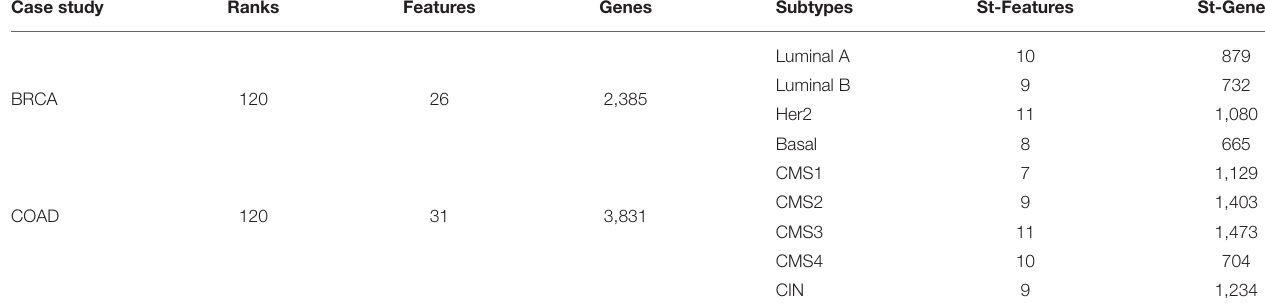
TABLE 1 | The number of selected features and genes in BRCA, COAD, and STAD. Case study